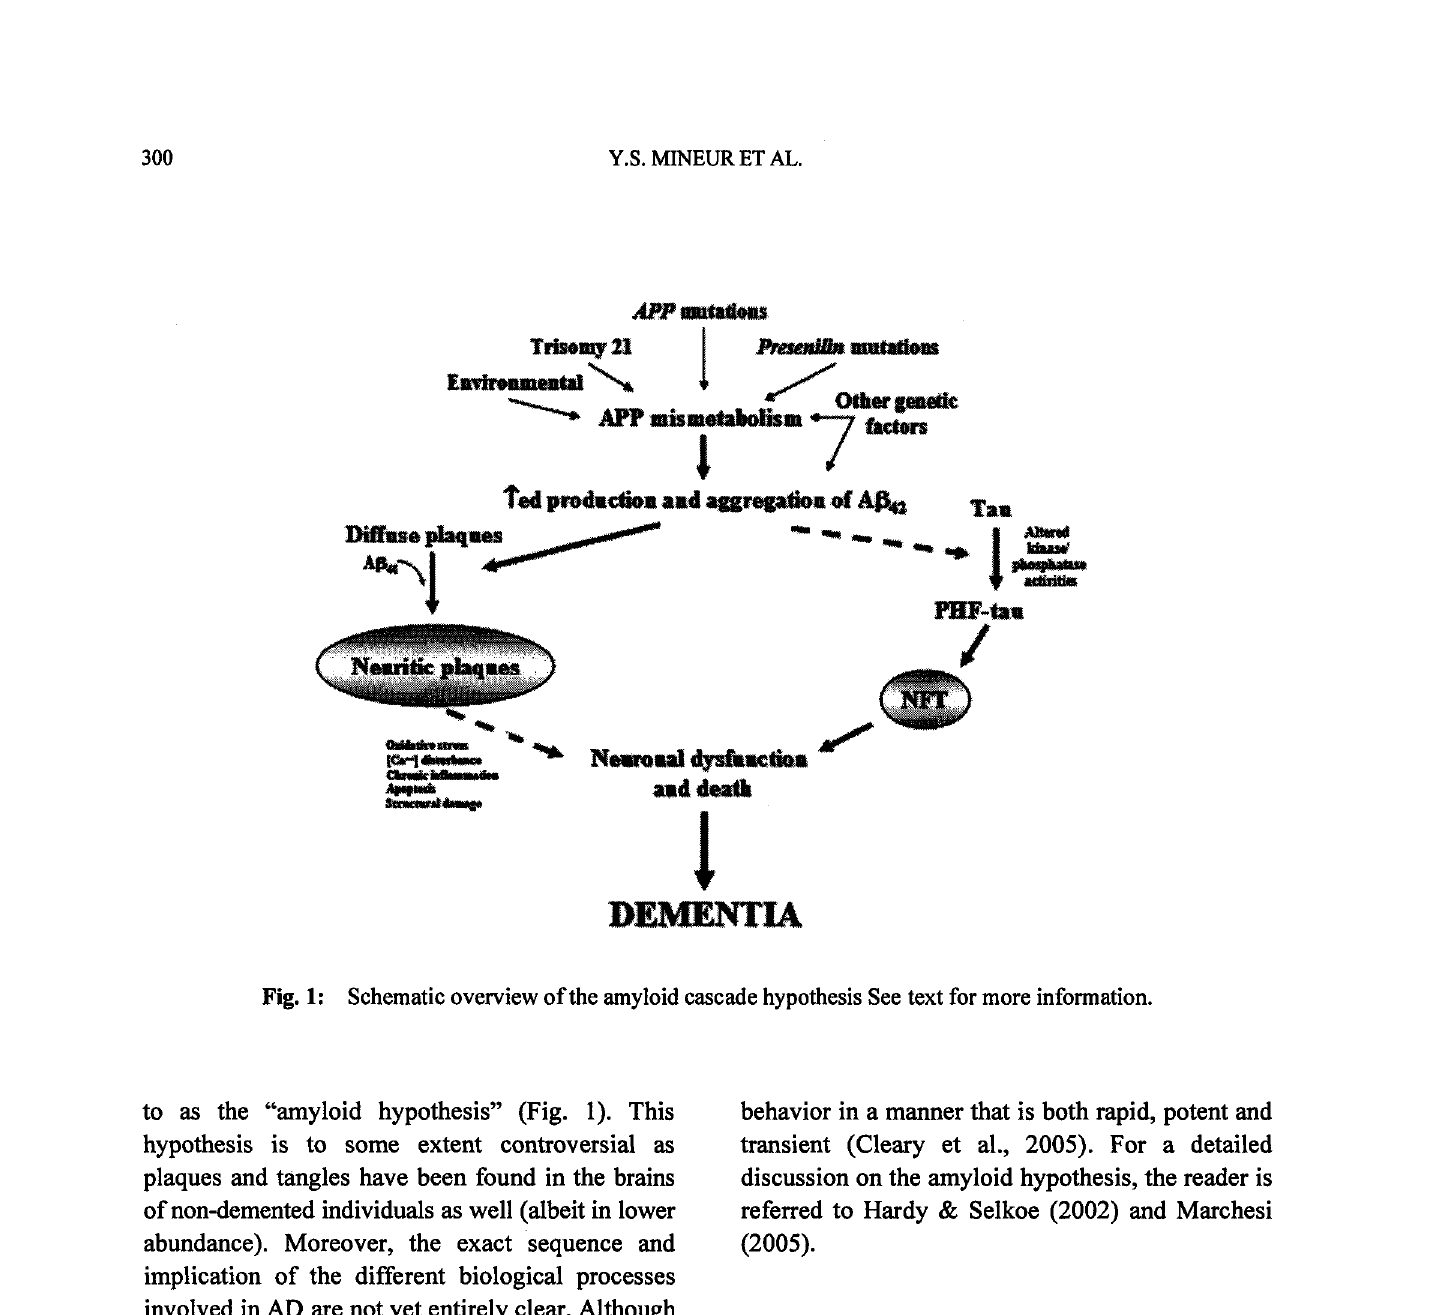
Fig. 1: Schematic overview of the amyloid cascade hypothesis See text for more